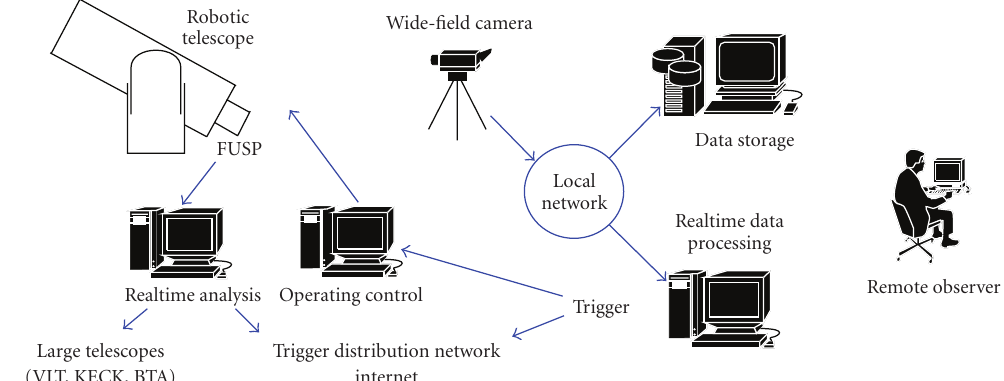
Figure 4: General scheme of a two-telescope complex for autonomous detection and investigation of short optical transients. The robotic telescope is equipped with FUSP and is meant to study transients detected by a wide-field monitoring camera in a few seconds after their onset.